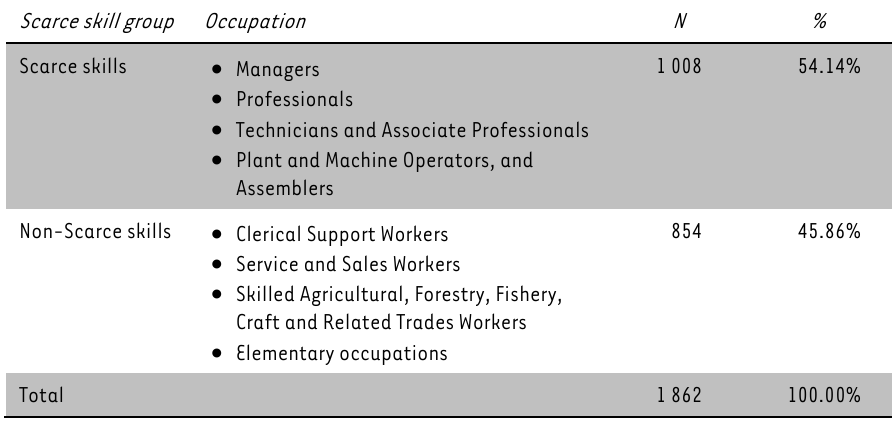
TABLE 8: Net equity distribution of scarce skills and non-scarce skills occupations Scarce skill group Occupation